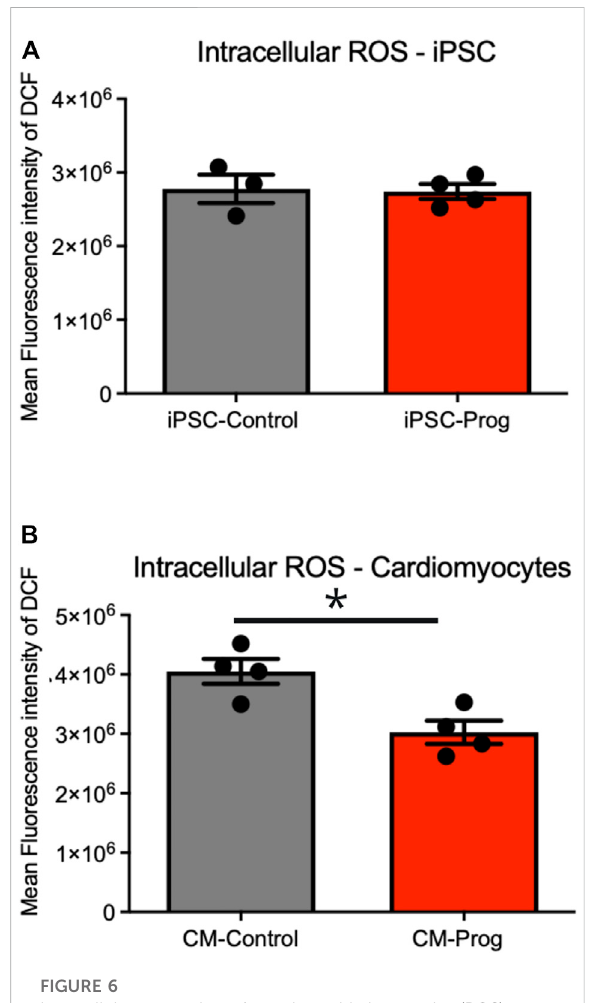
Intracellular generation of reactive oxidative species (ROS). Intracellular ROS production in iPSCs (A) and iPSCs derived cardiomyocytes (B) from cellular differentiations. Columns represent mean values and bars SEM. * indicates p < 0.05 between groups with non-parametric Mann-Whitney